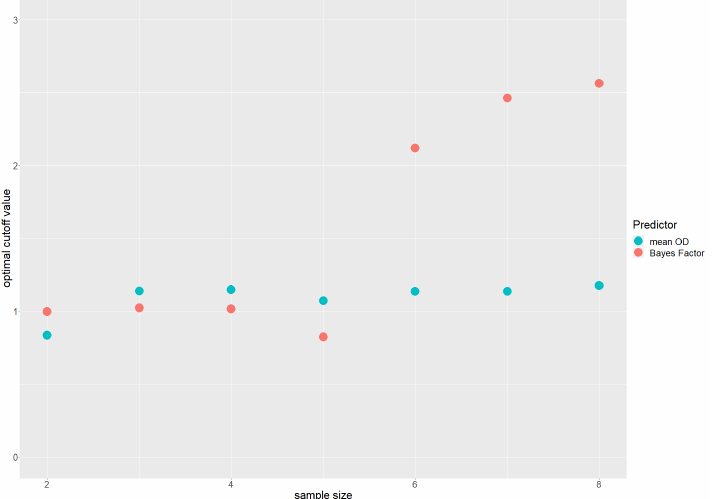
Figure 5. The optimal cutoff values are shown for the predictors average OD value (green) and Bayes factor